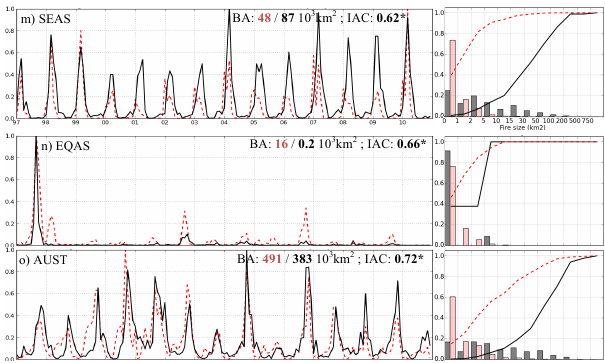
Figure 8. Comparison of HESFIRE with observation-derived data over the 14 regions of Fig. 7. Left plots: time series of normalized monthly burned area, with quantification of average annual burned area in GFED and in HESFIRE, and their interannual Spearman’s correlation. Right side: 2005 distribution of fires by size class and cumulative burned area along these classes. Observation data are from the MODIS MCD45 product. An asterisk (*) indicates signif- icance of the Spearman’s correlation between the GFED and HES- FIRE annual time series ( p <0.05, Spearman,